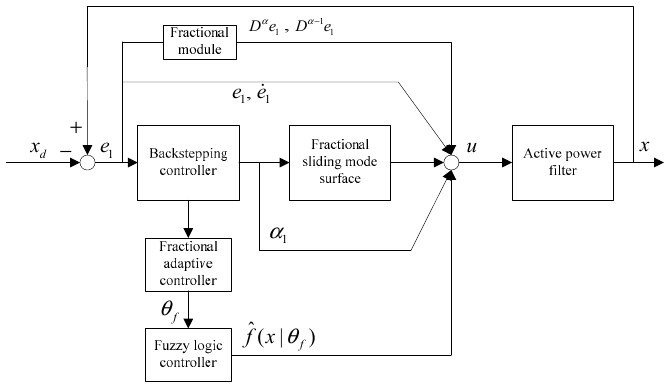
Figure 2. Block diagram of fractional-order backstepping sliding adaptive fuzzy controller.